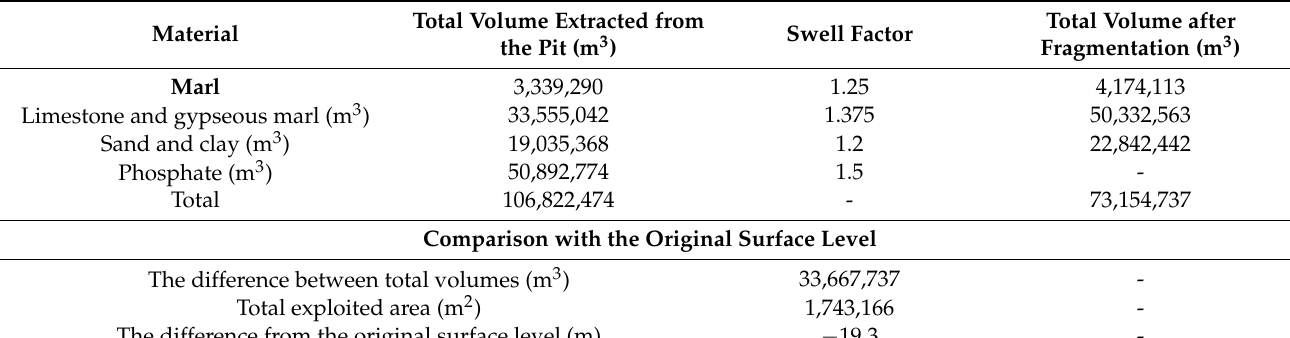
Table 2. Comparison of the extraction wastes with the original surface level of the exploited area. Material